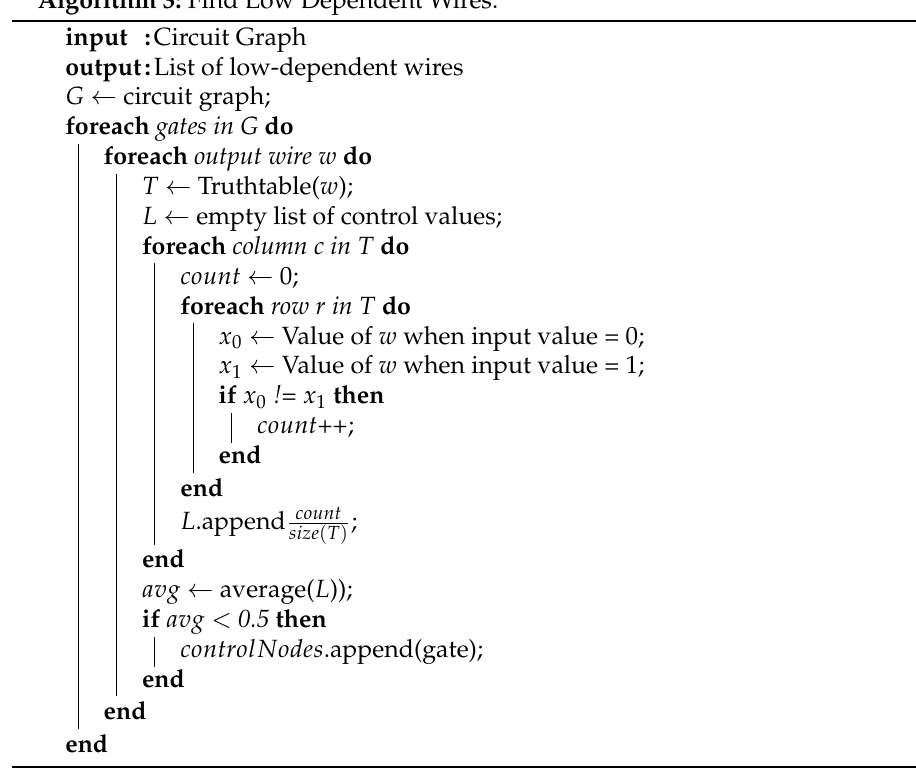
Algorithm 3: Find Low Dependent Wires.